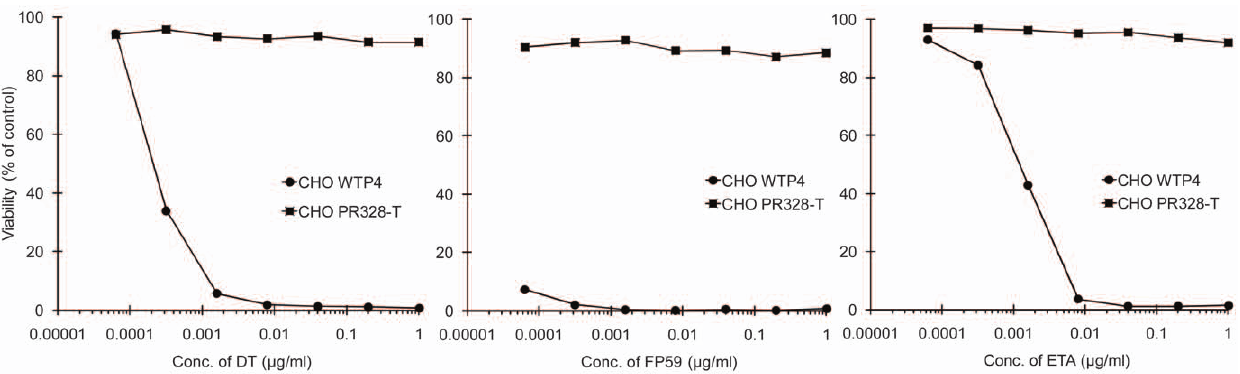
Figure 4. Effect of toxin exposure on CHO PR328 cells for subsequent cytotoxicity to toxin. CHO PR328 cells were treated with PA + FP59 (1 m g/ml) for 48 h and then placed into fresh medium lacking toxin. Cells grown for an additional two days are designated CHO PR328-T. In toxicity assays, cells were treated with different concentrations of FP59 at a fixed concentration of PA (500 ng/ml) for 48 h and then MTT assay was performed to measure cell viability. CHO WTP4 cells were included as control in the